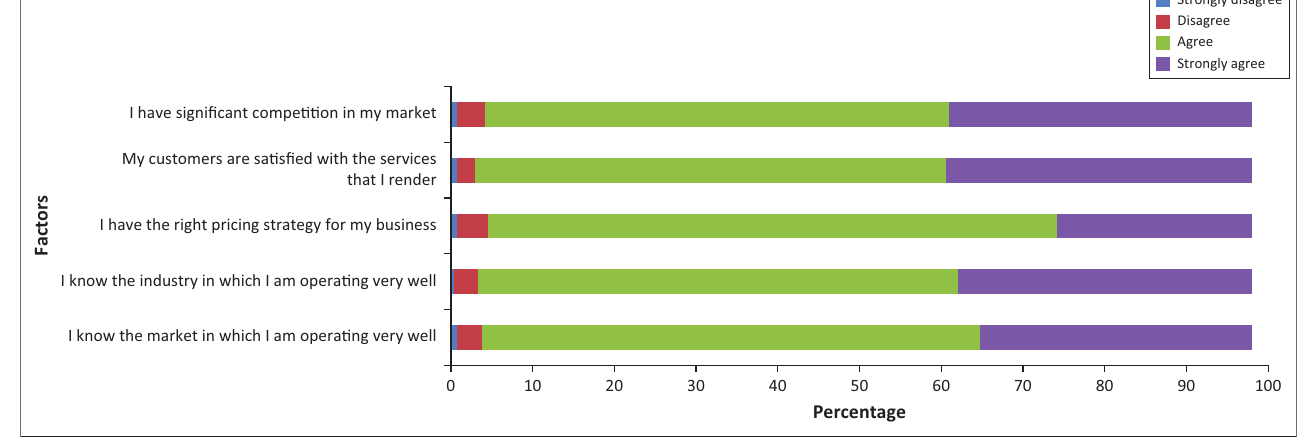
FIGURE 5: Market-related factors.